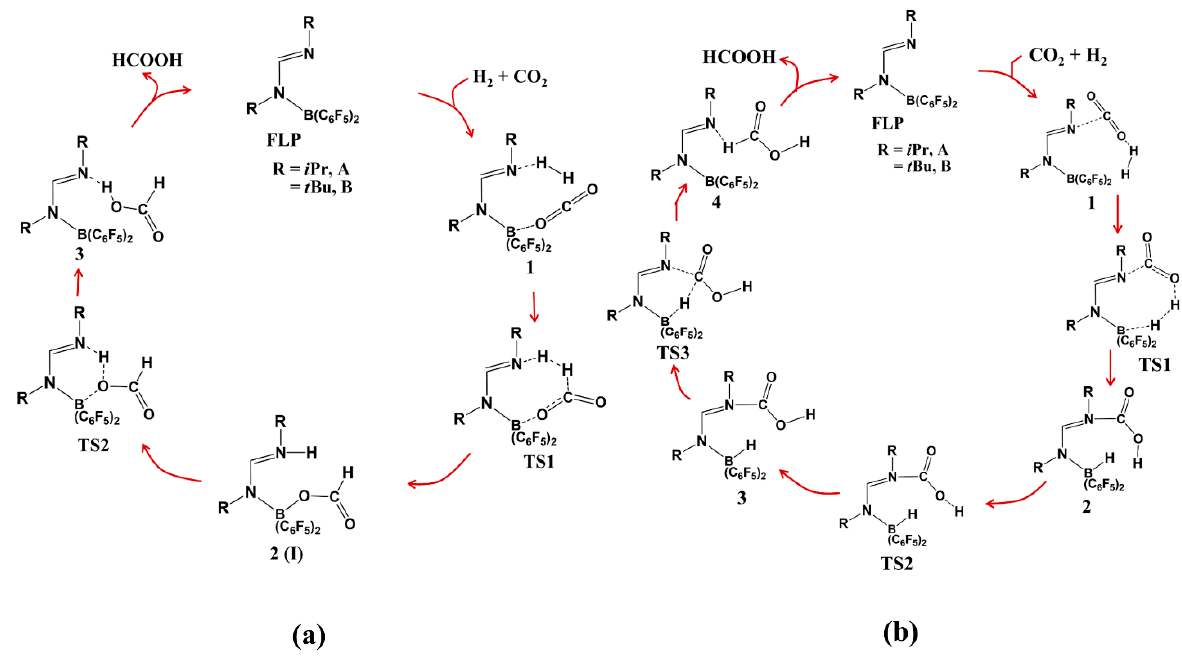
Figure 6. Proposed mechanistic cycles for hydrogenation of CO 2 catalyzed by FLPs A and B , where Lewis base of FLP activates ( a ) H 2 and ( b ) CO 2. (Reprinted from ref. [87] with permission from Springer Nature. Copyright © 2022, Springer Science Business Media, LLC).